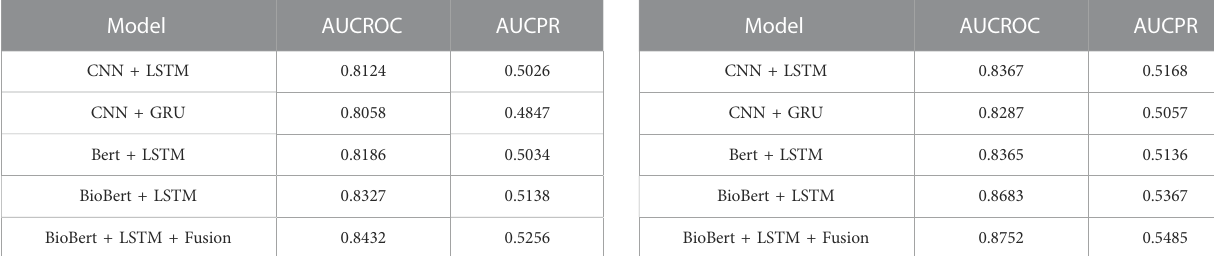
TABLE 2 Performance of each model in the one clinical record.